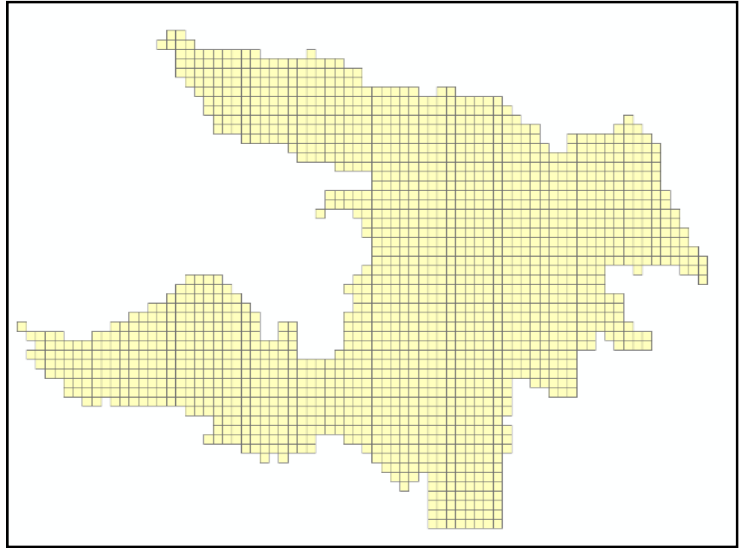
Figure 3. Zhicheng’s grids after rasterization.